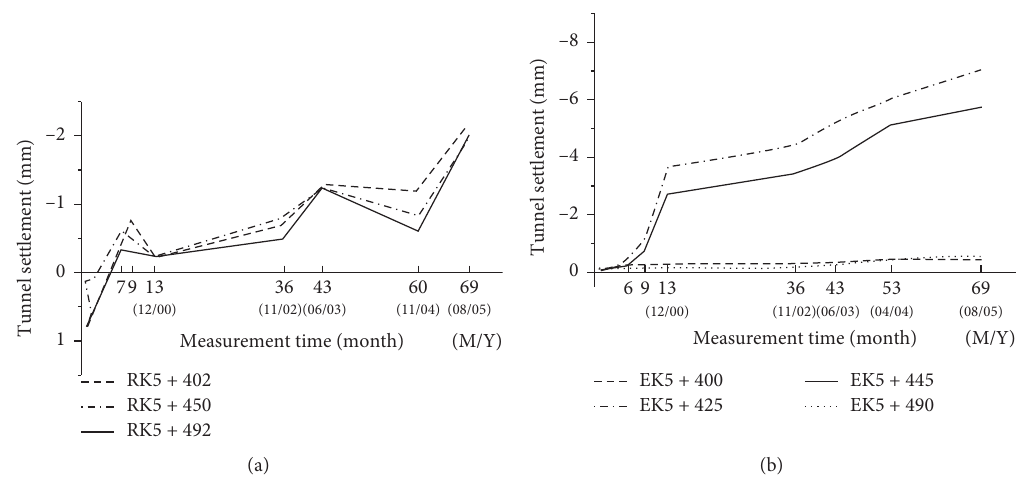
Figure 7: Variations in tunnel settlement before construction: (a) westbound tunnel and (b) eastbound tunnel.